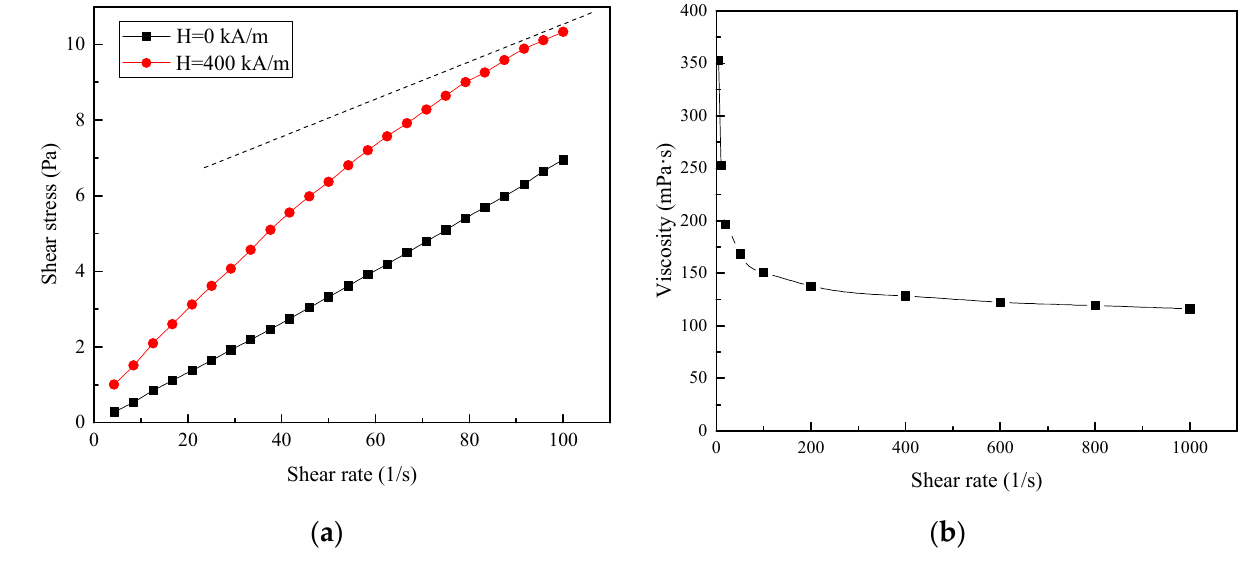
Figure 3. ( a ) Shear stress versus the shear rate of diester-based magnetic fluids at magnetic fields of 0 kA/m and 400 kA/m; ( b ) viscosity versus the shear rate at 400 kA/m. Magnetic fluids produce magnetic viscous effects under a magnetic field, and the variation in viscosity with respect to the magnetic field was measured experimentally at a shear rate of 1000 s − 1 , as indicated in Figure 4. Viscosity initially increased significantly with the enhancement of the magnetic field; then, viscosity no longer changed significantly and reached the approximate saturation state when the magnetic field was strong enough (>400 kA/m). The average magnetic field strength within the gap of a high-speed